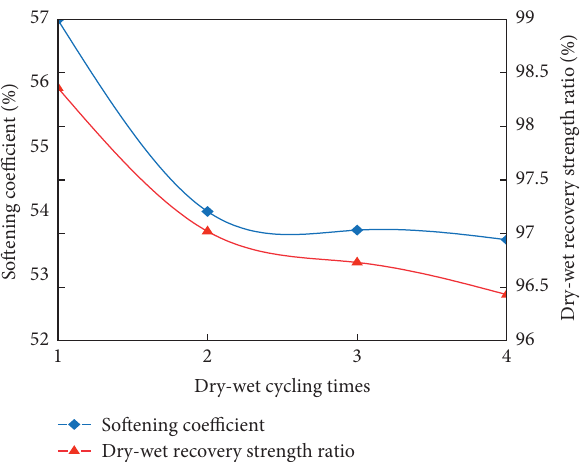
Figure 19: . Softening coefficient and dry-wet recovery strength ratio at different dry-wet cycles. Table 6: Freezing stability performance of SSGM after the first freeze-thaw cycle test.